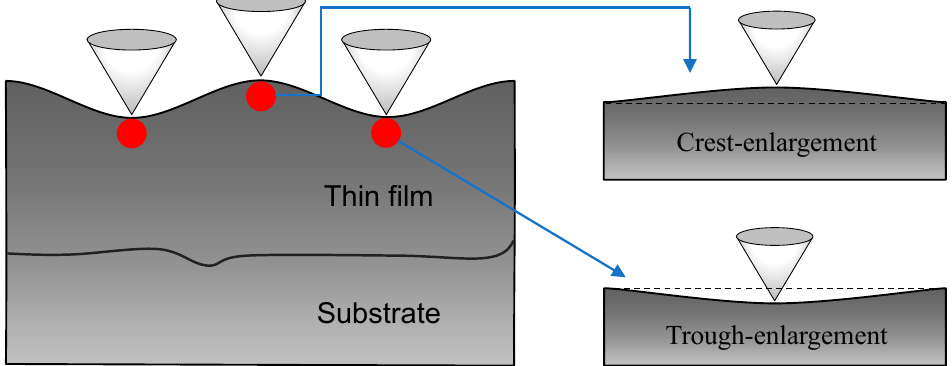
Figure 4. Partial magnifications of contact positions on the two-dimensional sinusoidal surface.